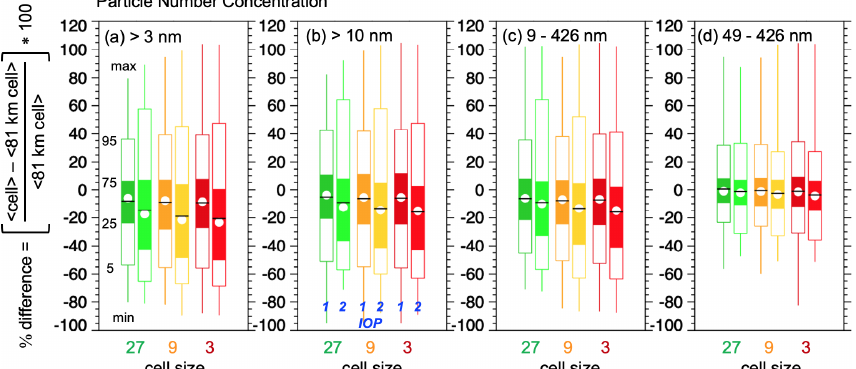
Figure 8. Percent difference between the SGP 81km cell average and the 27, 9, and 3km cell averages of number concentrations with particle diameters (a) > 3nm (CPC3025), (b) > 10nm (CPC3010), (c) 9–426nm (FIMS), and (d) 49–426nm (FIMS). The definition of percentiles and average values is the same as Fig. 5. All flights during IOPs 1 and 2 are grouped by the darker (left) and lighter (right) colors,